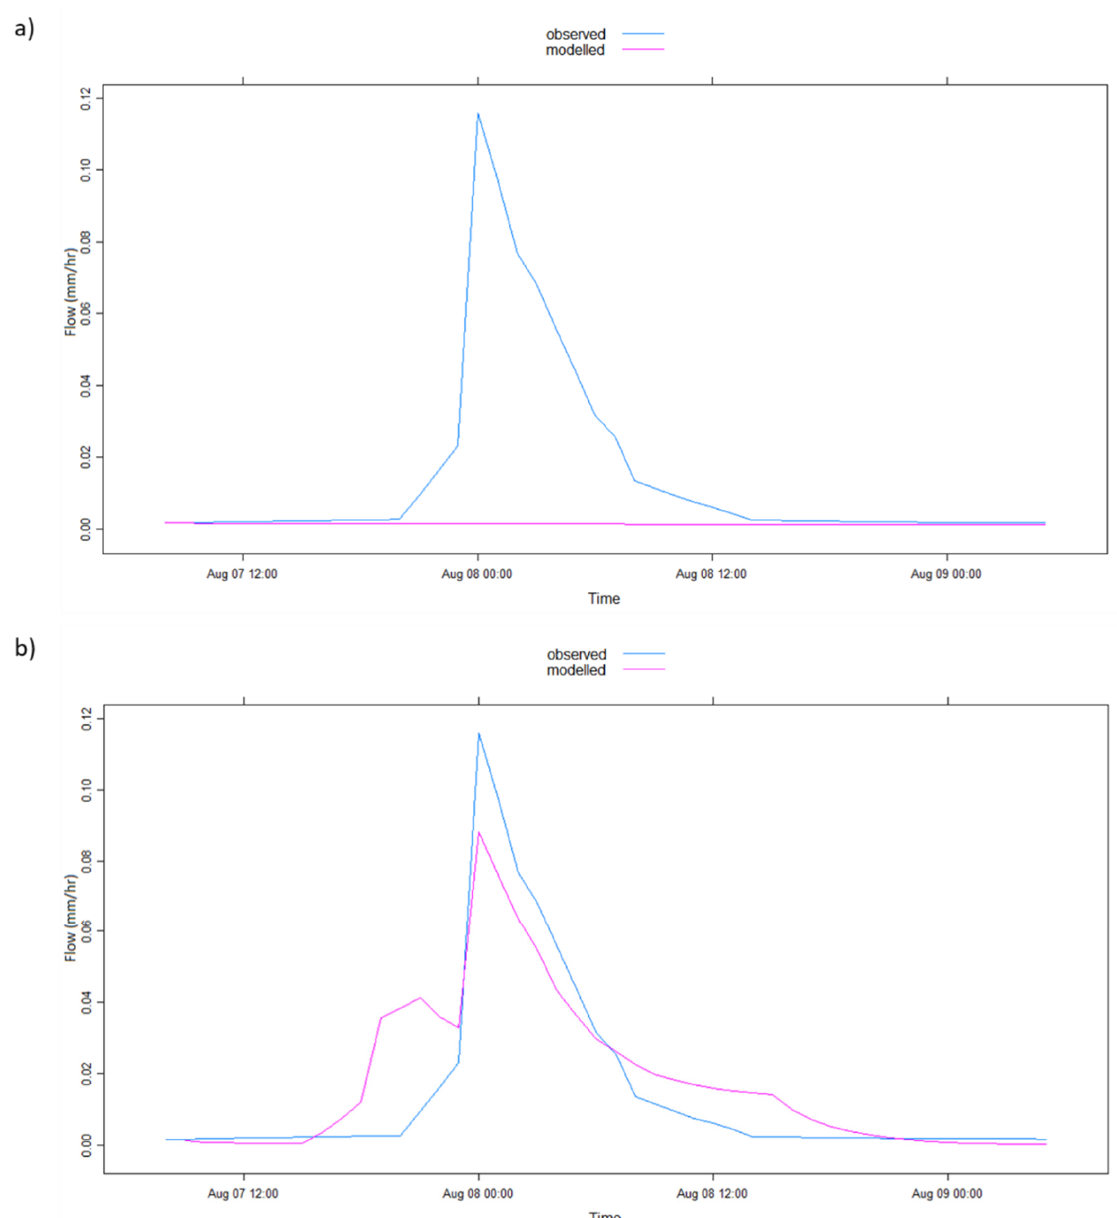
Figure 7. IHACRES model simulation results with ( a ) rsq_daily and ( b ) rsq_hourly objective functions for the 2003 flood event.